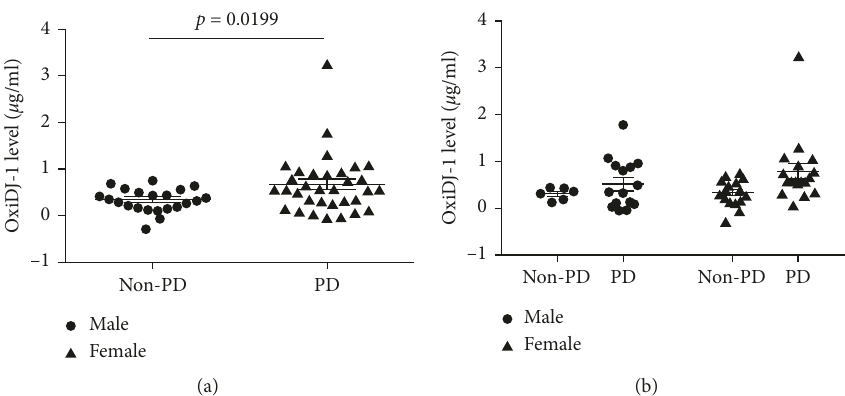
Figure 4: Detection of OxiDJ-1 from urine samples using ELISA. (a) OxiDJ-1 levels in urine were significantly increased in PD patients compared to non-PD controls. Student’s t -test was used for this analysis, and p value is described in the graph. (b) OxiDJ-1 levels in urine were divided by gender. One-way ANOVA was used for statistical